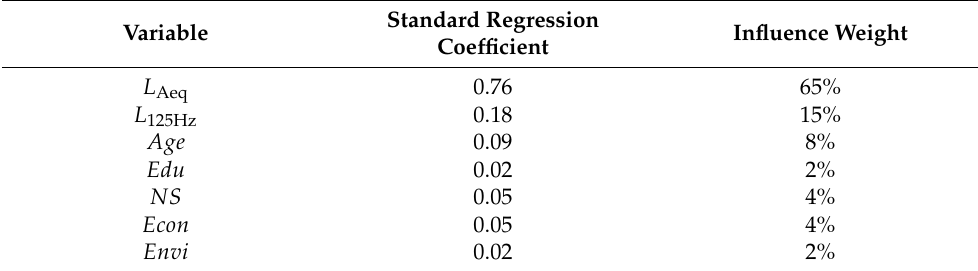
Table 4. The standard regression coefficient of each variable in the